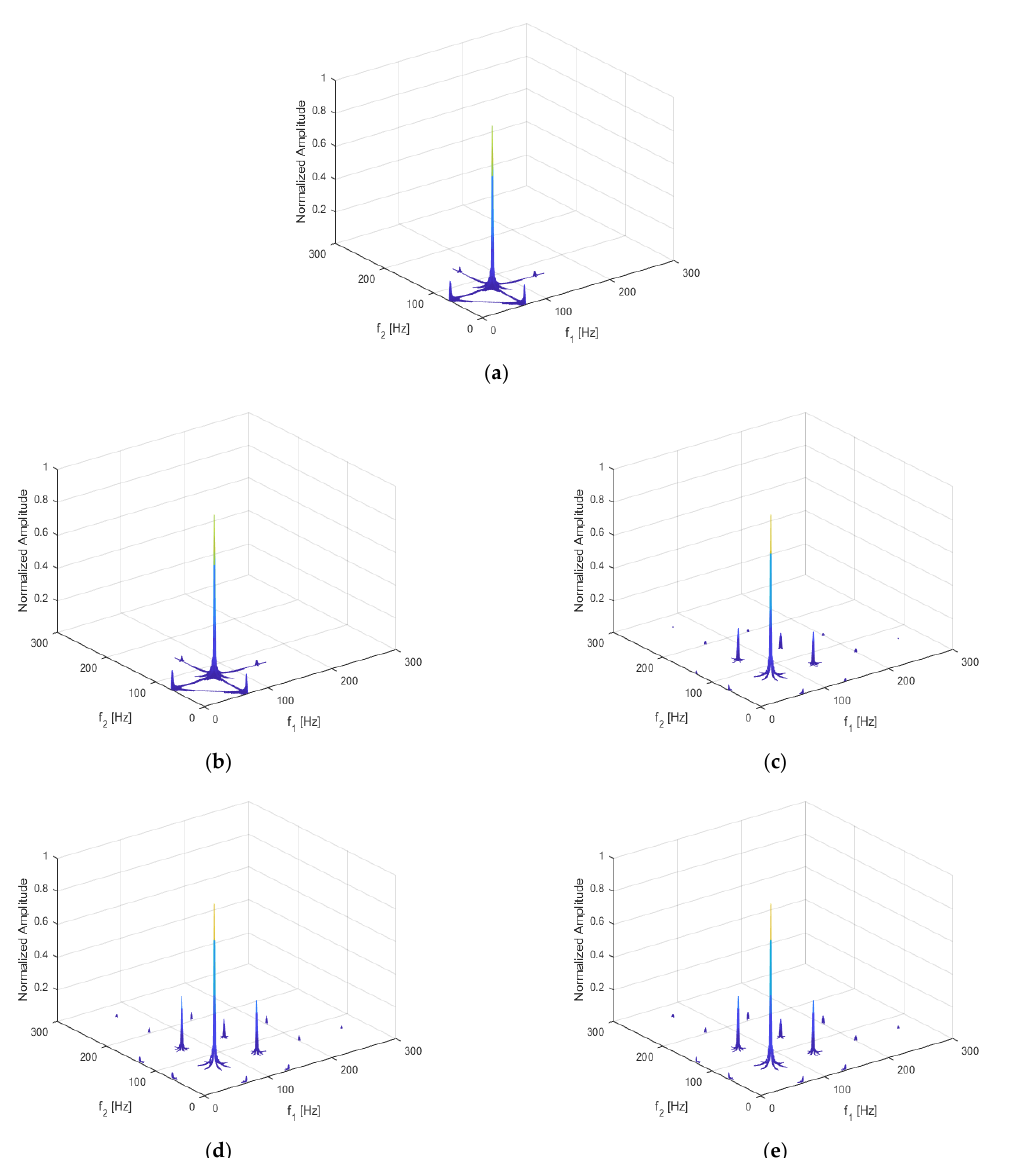
Figure 6. Bispectrum when ( a ) p = 0.1; ( b ) p = 0.2; ( c ) p = 0.3; ( d ) p = 0.4; ( e ) p = 0.5.